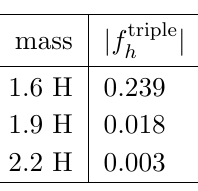
Table 6 . NG mediated by h via triple exchange diagram in single-(cid:12)eld slow-roll in(cid:13)ation.